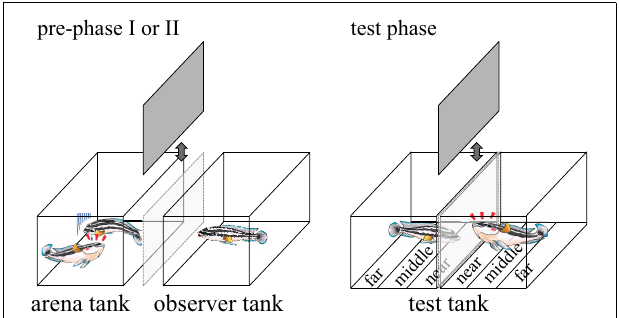
FIGURE 1 | Pictures of an arena tank, an observer tank (used in the pre-phase I and II) and test tanks (used in the test phase). These tanks all measured 30 × 18 × 20cm 3 (W × D × H). The arena tank and the observer tank were separated with 7cm distance. Movable opaque sheets are between the arena tank and the observer tank, and between the two adjacent test-tanks. The bottom of the test tanks was divided into three zones: near, middle and far zones, each having a width of 6cm.